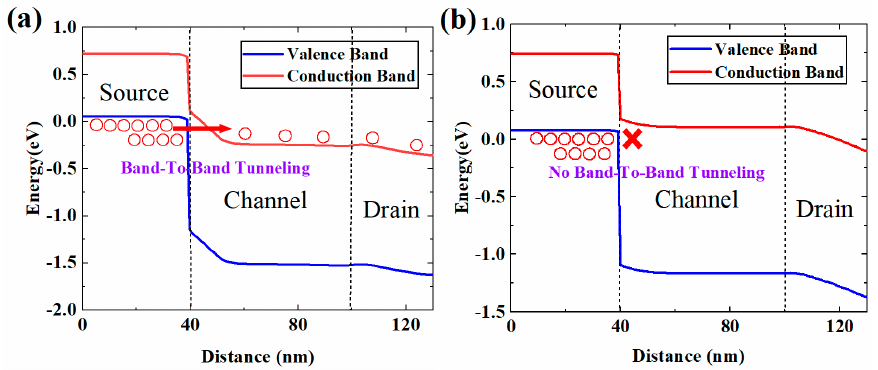
Figure 2. Band diagram in the ( a ) ON-state and ( b ) OFF-state.